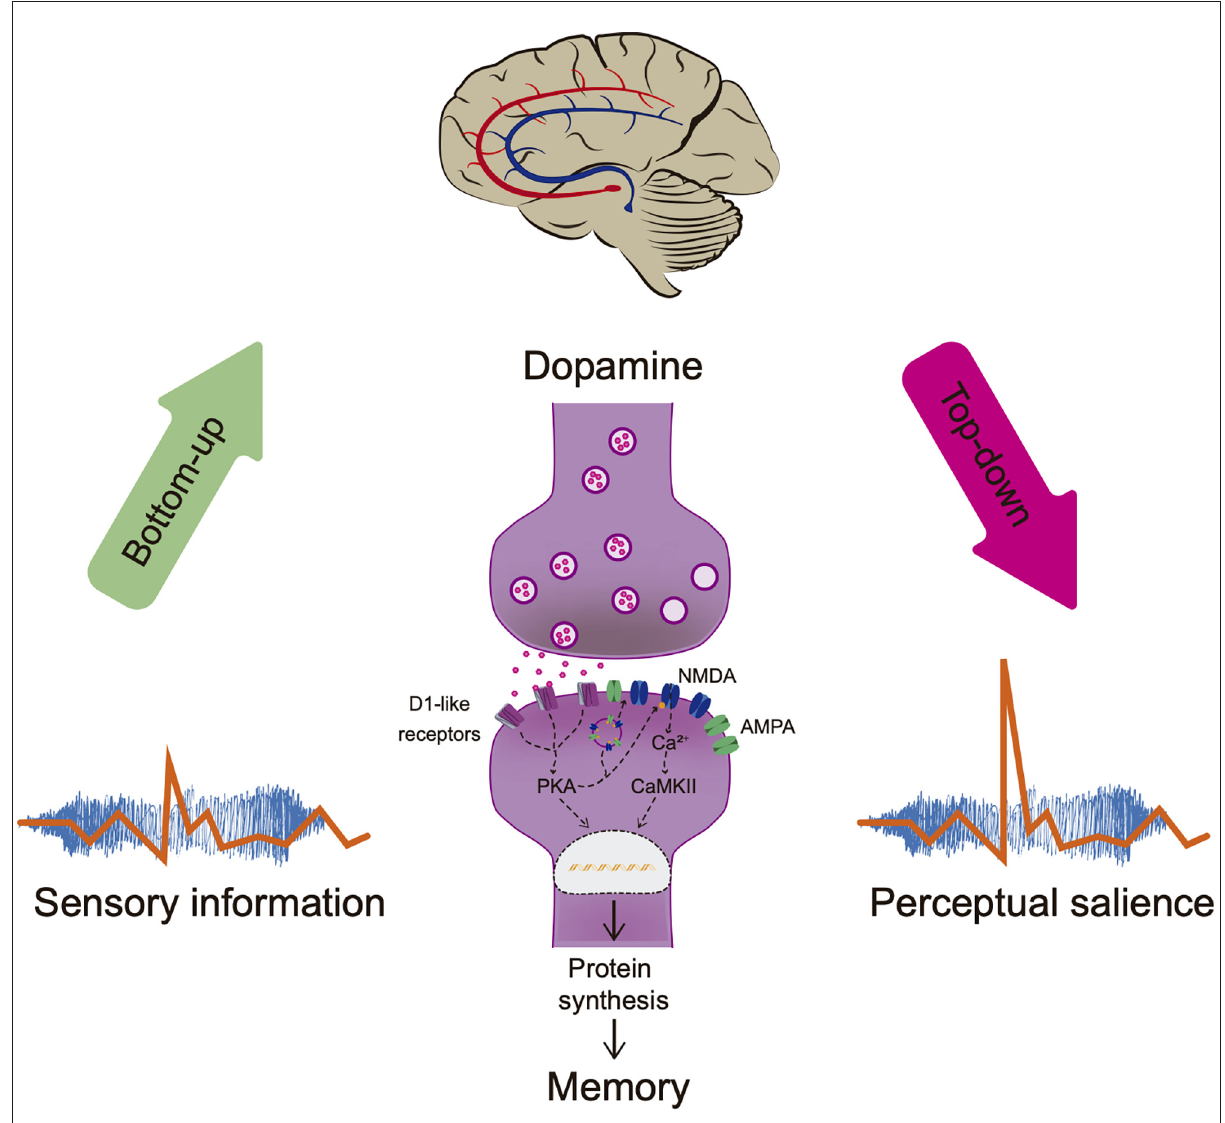
FIGURE2 Perceptual salience. Sensorial stimulation attracts attentional resources bottom-up facilitating information processing. Brain hierarchizes salient